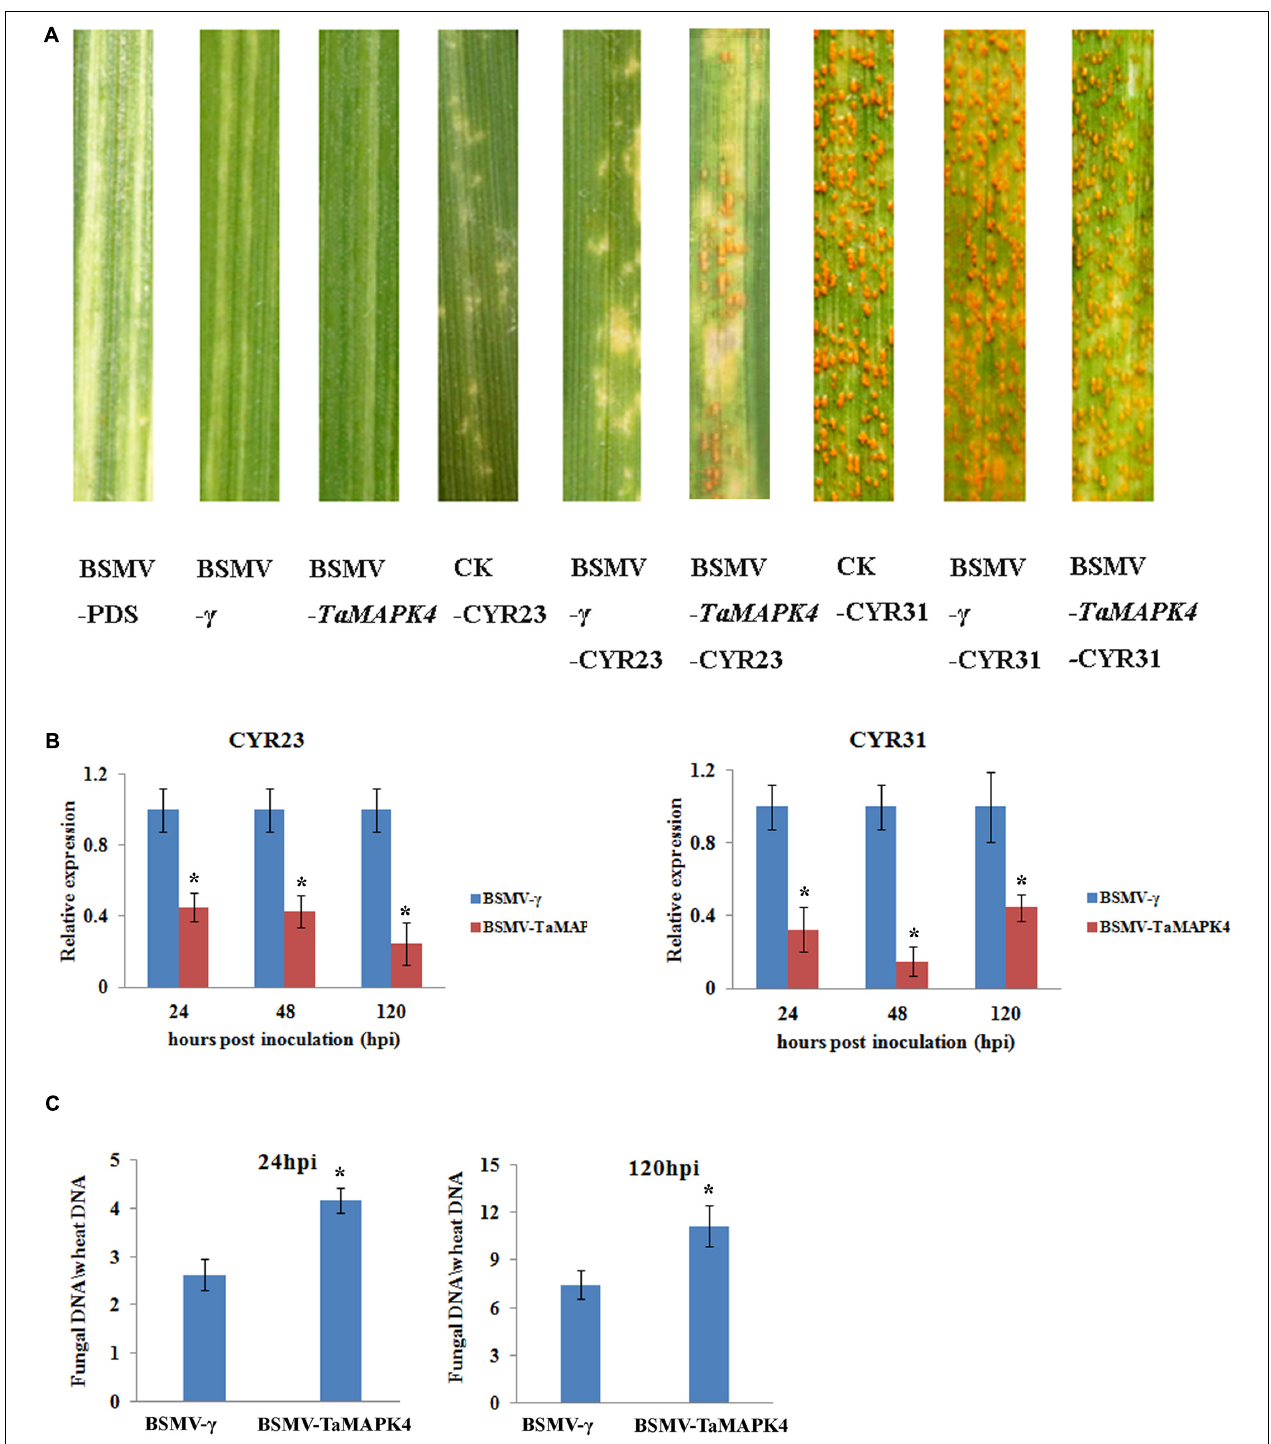
FIGURE 4 | Functional characterization of TaMAPK4 after virus-induced gene silencing. (A) Phenotypic changes in the fourth leaves of plants pre-inoculated with positive control vector (BSMV-PDS), FES buffer (CK), or empty BSMV vector (BSMV- γ ) at 14 days post-virus treatment. Phenotypes for the fourth leaves inoculated with Puccinia striiformis f. sp. tritici ( Pst ) races CYR23, or CYR31 at 14 dpi. (B) Relative transcript levels of TaMAPK4 in TaMAPK4 knockdown leaves. RNA samples were isolated from TaMAPK4 knockdown leaves infected with Pst races CYR23 (left), or CYR31 (right). BSMV- γ leaves infected with Pst races CYR23, or CYR31 were used as control, respectively. (C) Biomass of Pst (CYR23) measured at 24 and 120 hpi. Means and standard deviations were calculated from three independent replicates. Significant differences were determined using Student’s t -test: ∗ P < 0.05.